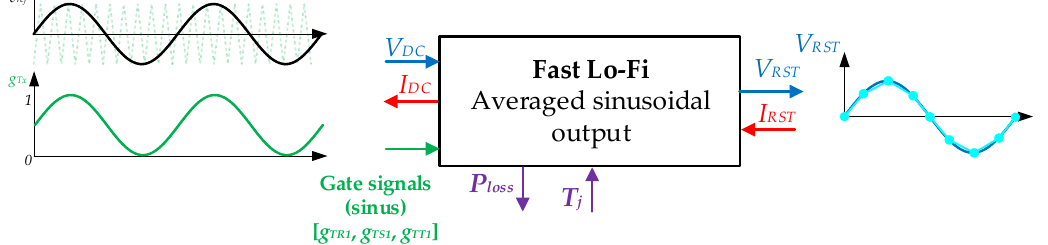
Figure 13. Lo-Fi model block. ( Left ) DC voltage and current, and the gate input low frequency PWM signal. ( Right ) AC voltage and currents. On the lower side, the thermal and power variables are shown. Table 1. Summary table of the four di ff erent